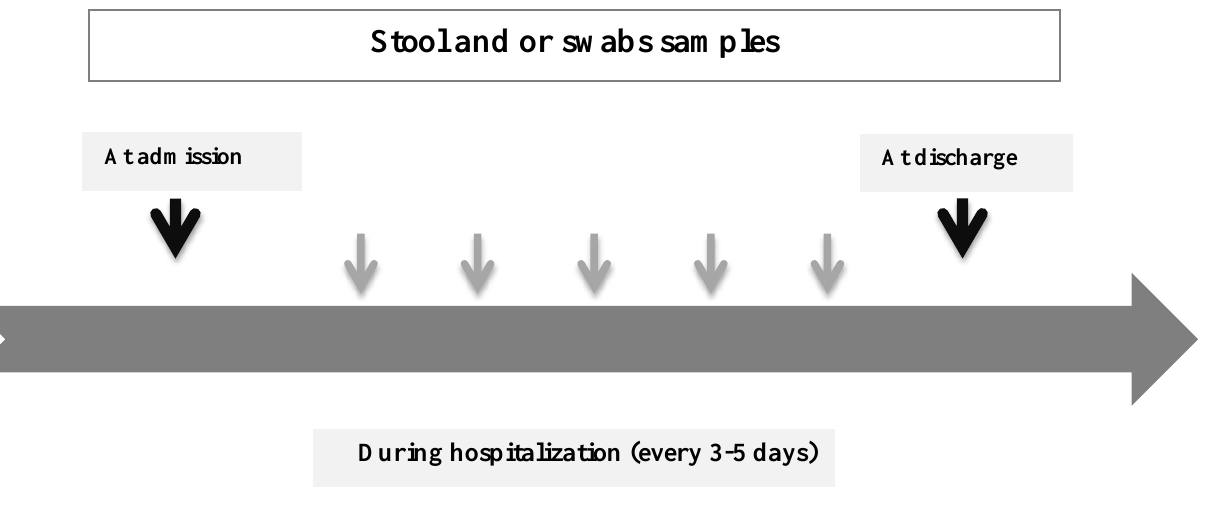
Figure 1. Clinical samples during ward Figure 1- Clinical samples during ward stay